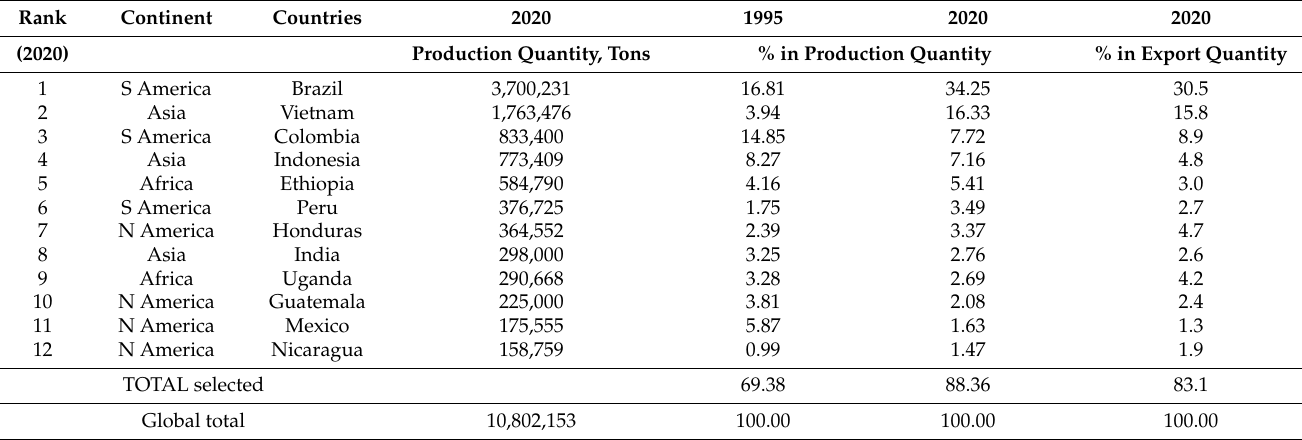
Table 1. The share of countries in total global production and export of coffee green beans.